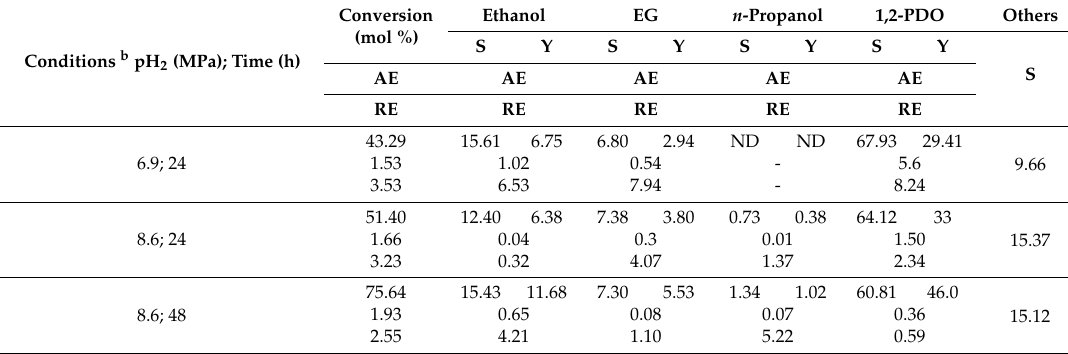
Table 3. Effect of initial hydrogen pressure and time a